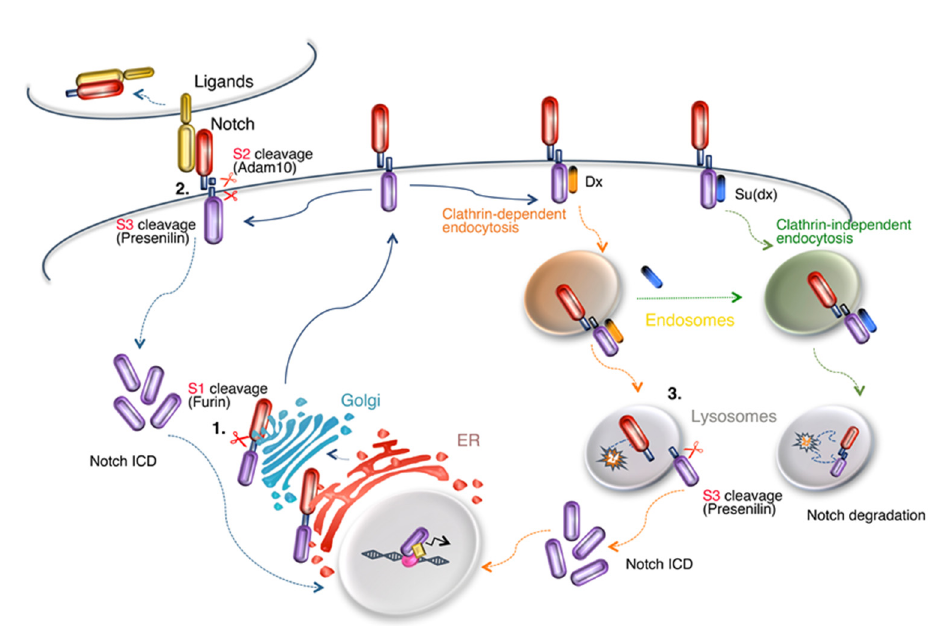
Figure 2. The life cycle of Notch. Schematic model of the synthesis, secretory and endocytic transport, activation and turnover of Notch. Locations in the cell where proteolytic cleavages can occur are indicated ( 1–3 ) and may be relevant to detachment of the Notch3 extracellular domain (ECD). ( 1 ) Notch is cleaved by furin while in transit in the Golgi to form a processed heterodimer. ( 2 ) At the cell surface, ligand interaction promotes exposure of the S2 cleavage site, which is a substrate for Adam10-dependent cleavage. The released ECD is endocytosed, along with bound ligand, into the signal-sending cell. ( 3 ) In Drosophila , Notch endocytosis is by both clathrin-dependent and -independent routes [20] respectively promoted by ubiquitin ligase regulators deltex (Dx) and suppressor of deltex (Su(dx)). Dx promotes ligand-independent activation of Notch following removal of ECD by an Adam10-independent mechanism and presenilin-dependent release of intracellular domain (ICD) through S3 cleavage. Su(dx) promotes Notch transfer to intraluminal vesicles of the endosome and degradation of the full-length receptor on lysosome fusion.